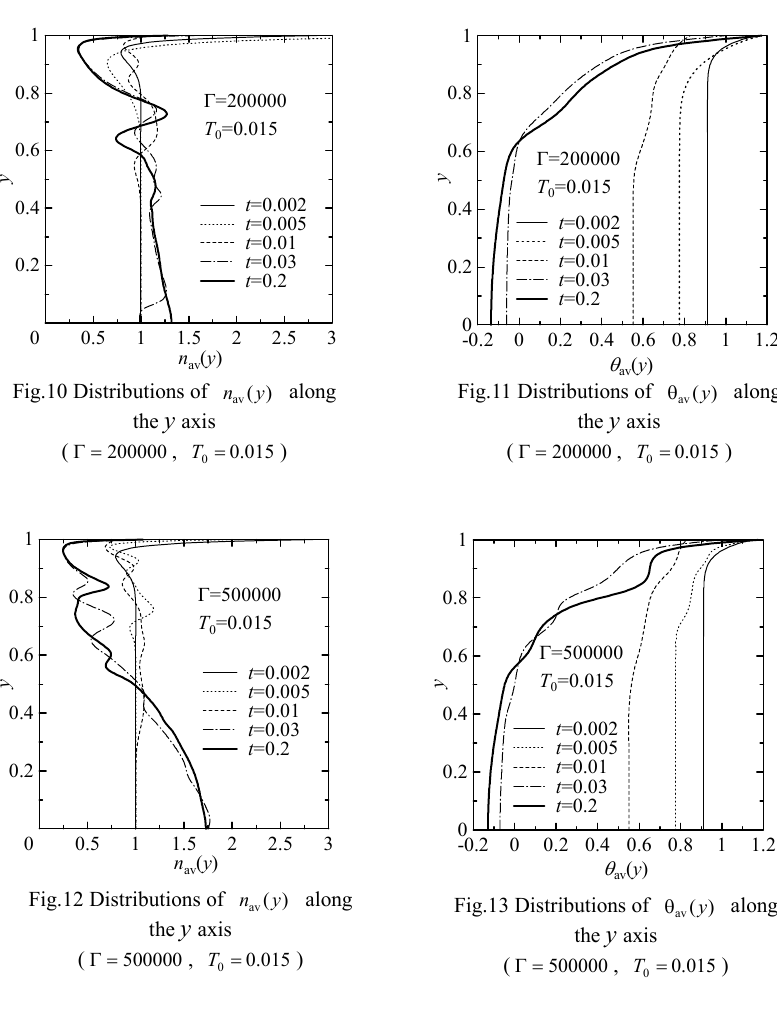
Fig.11 Distributions of along Fig.10 Distributions of )(